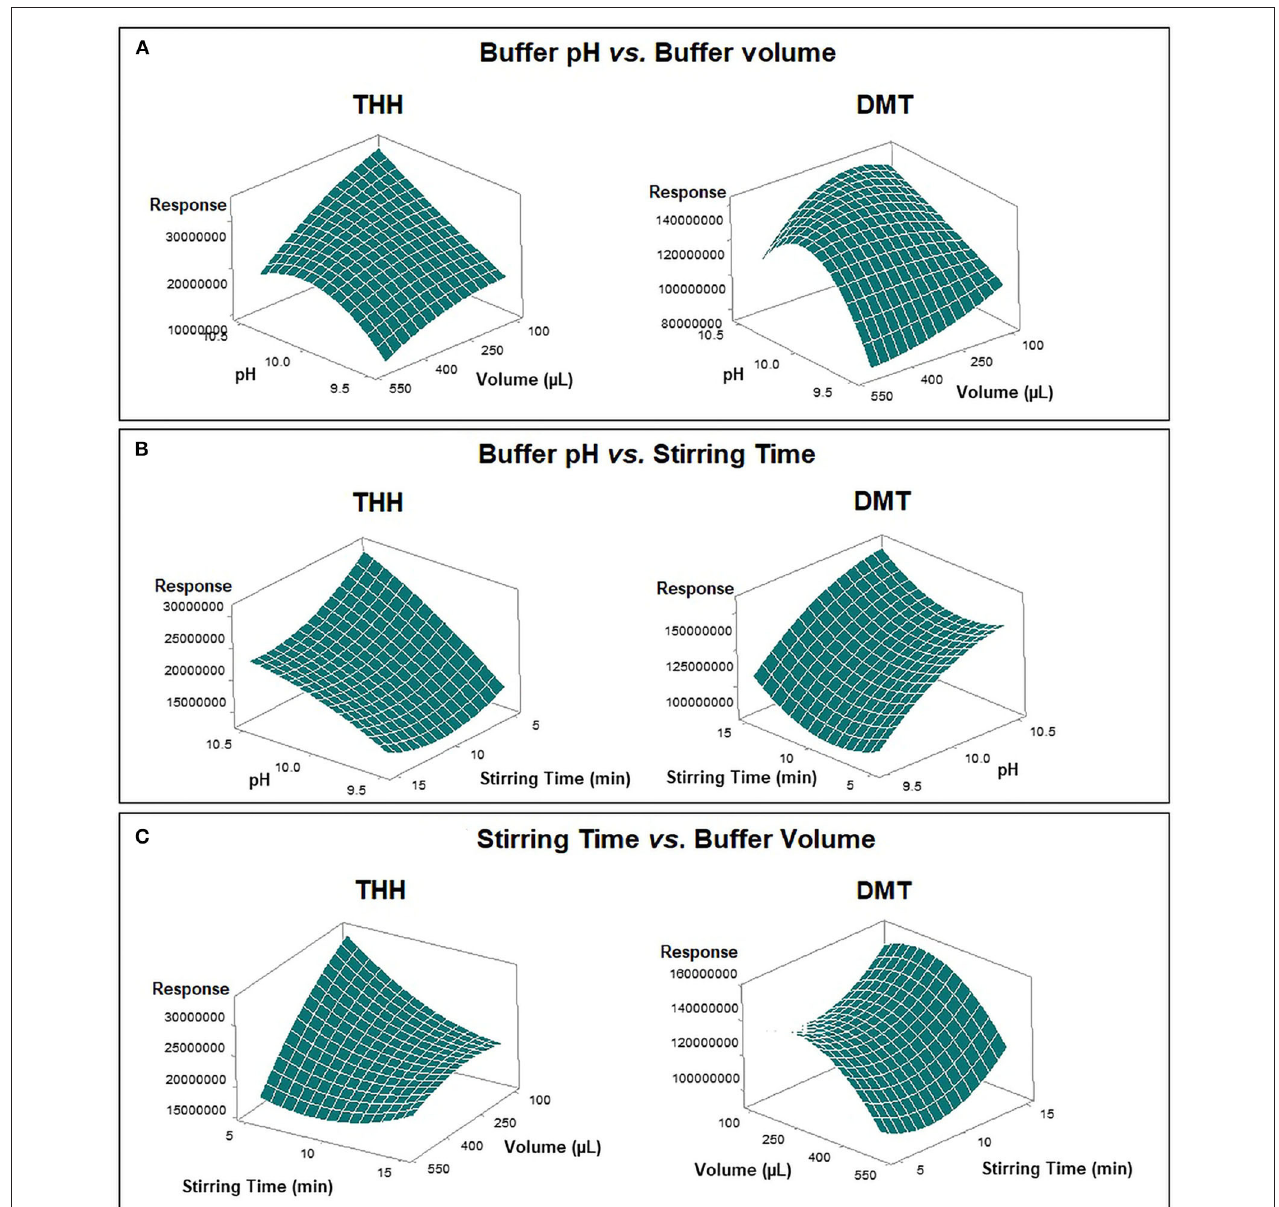
FIGURE 4 | Comparative response surface plots for absolute response areas of dimethyltryptamine (DMT) and tetrahydroharmine (THH) from Box–Behnken design. (A) Buffer pH vs. buffer volume. (B) Buffer pH vs. stirring time. (C) Stirring time vs. buffer volume.